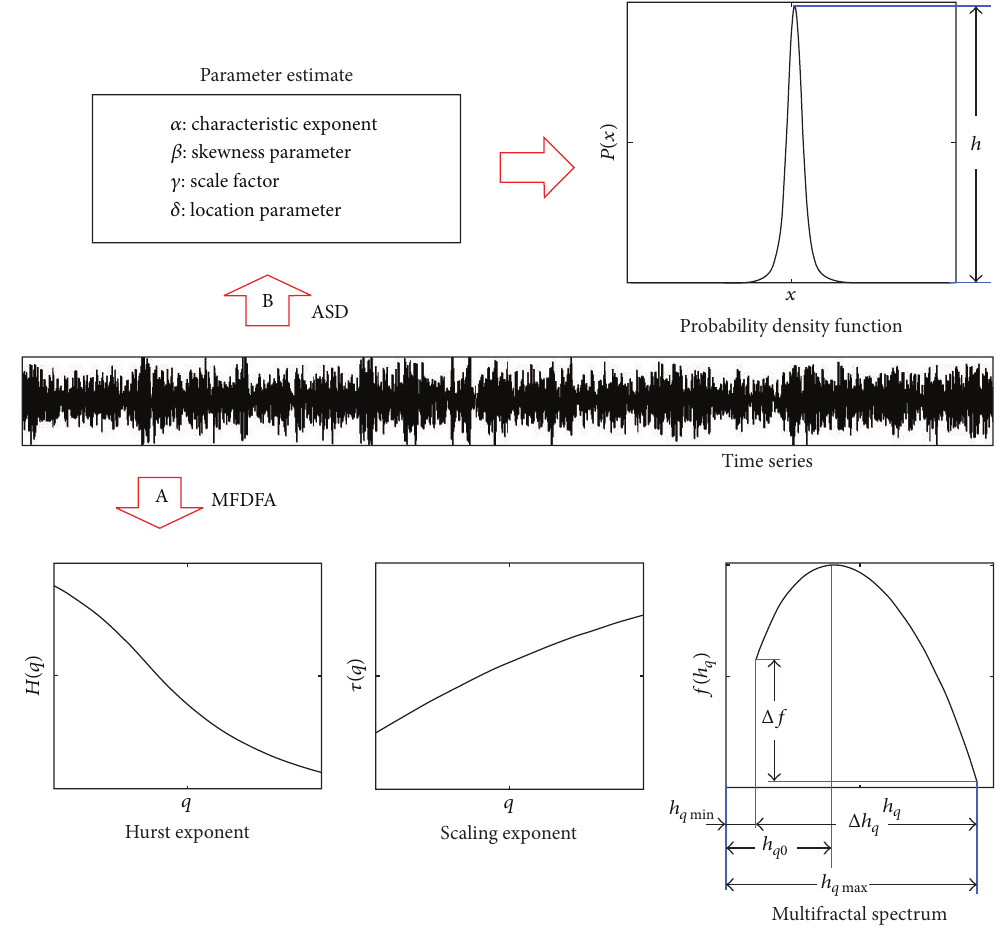
Figure 1: Schematic diagram of MFDFA features and ASD